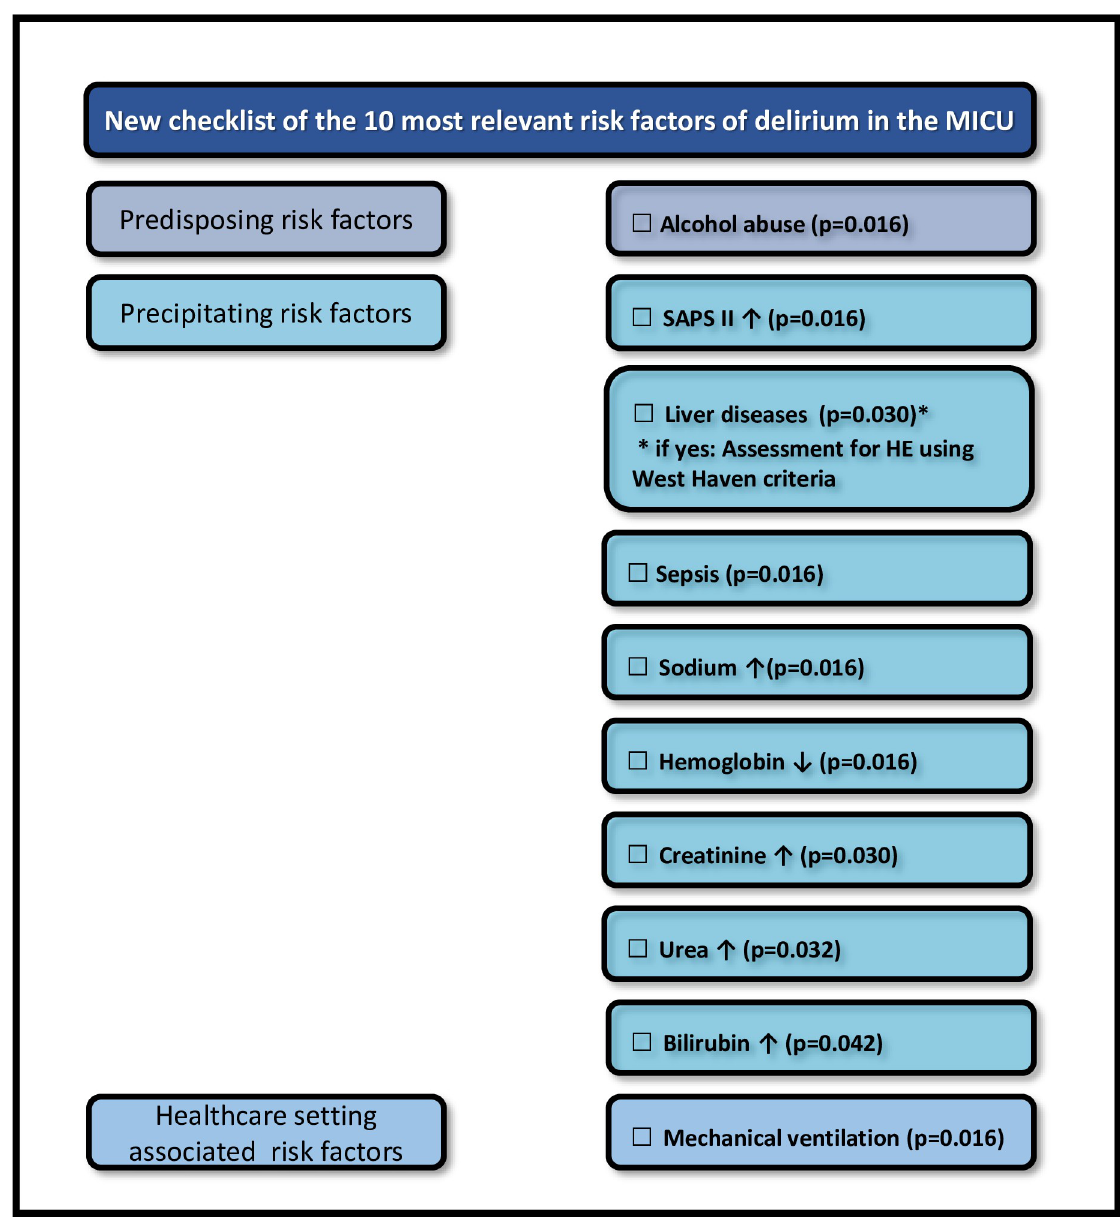
Fig 4. New checklist of the ten clinically most relevant risk factors for delirium in the MICU identified in this study. SAPS II = Simplified Acute Physiology Score, HE = Hepatic